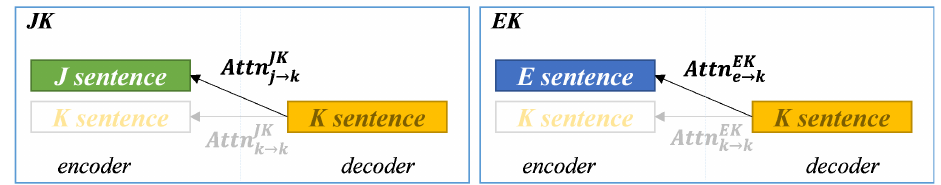
Figure 5. Comparison of cross-attentions between the different